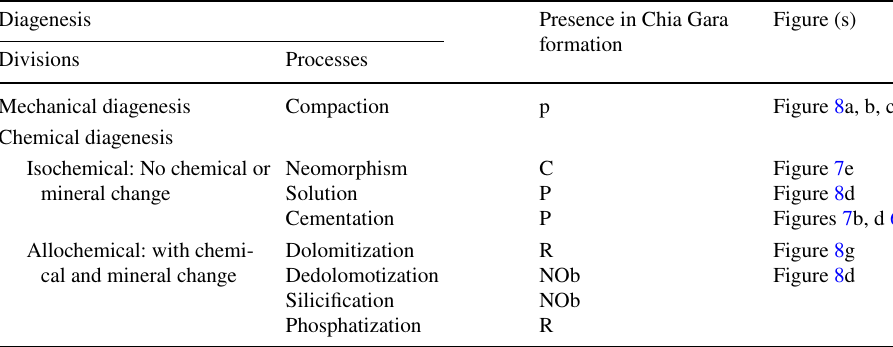
Table 3 Classification of diagenesis and its presence in the Chia Gara Formation (after Engelhardt 1977)